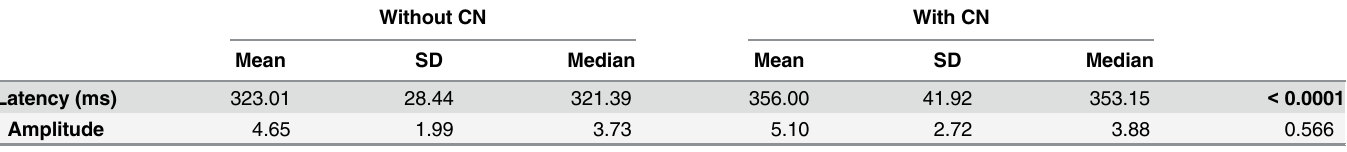
Table 2 shows the descriptive statistics of P300 latencies and amplitudes for the variable sex in both assessment conditions: with and without contralateral noise (CN) stimulation. There were no significant differences between male and female subjects for both latency and ampli- tude measures in both testing conditions.